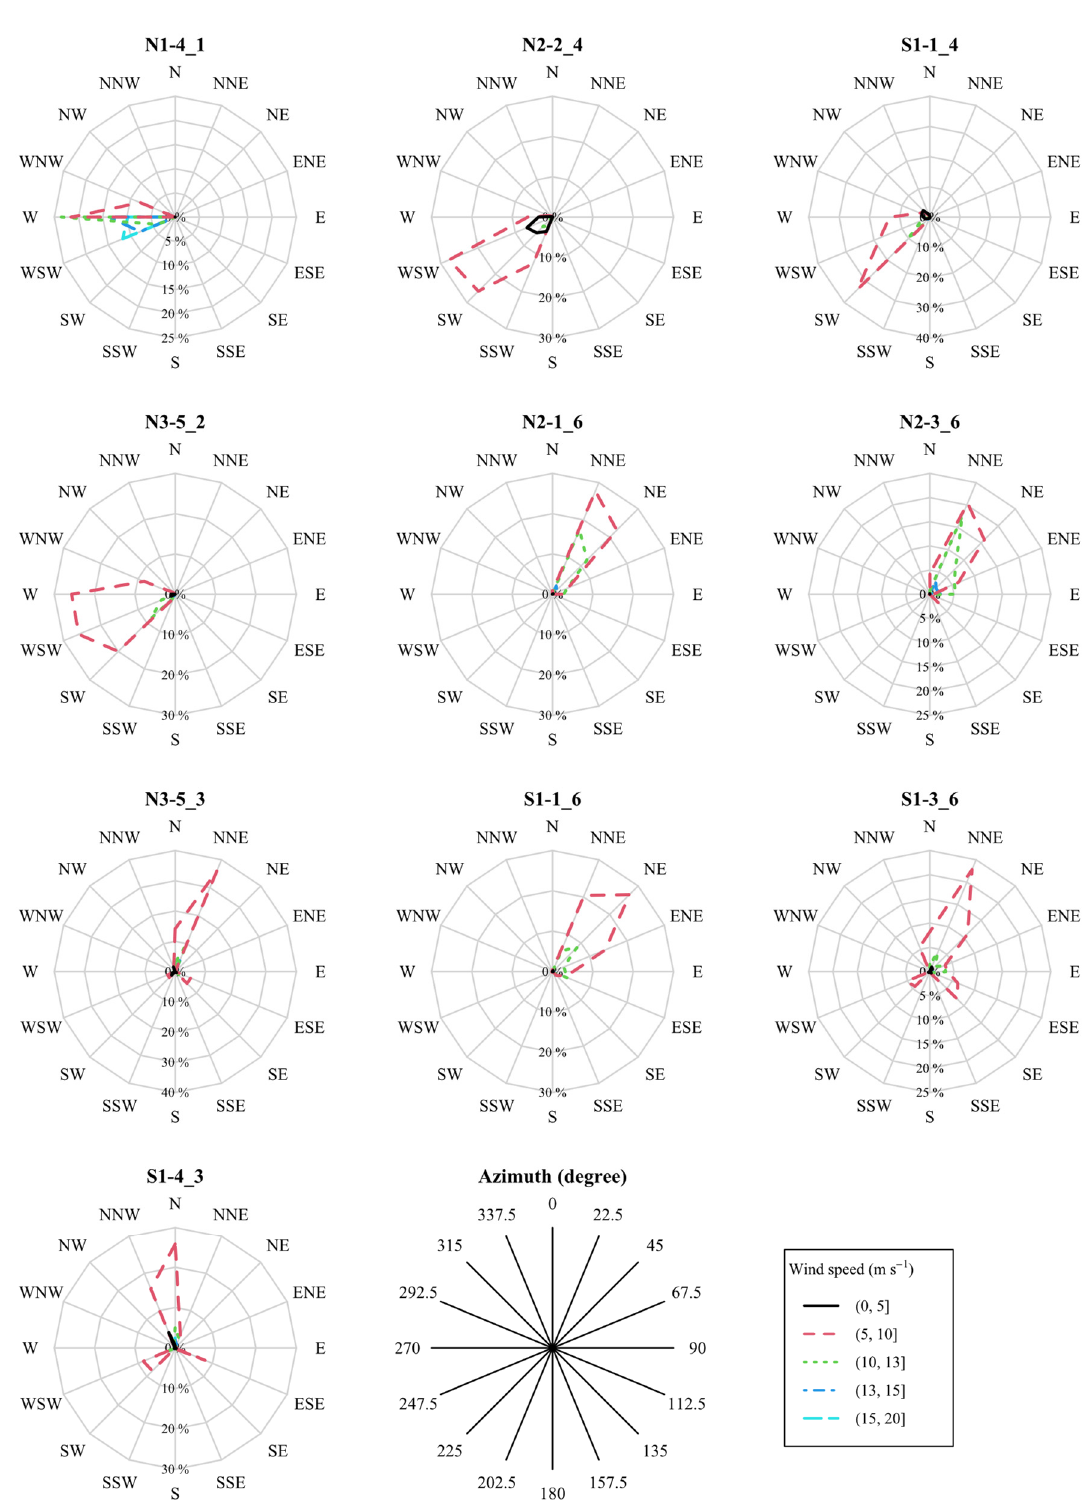
Figure 4. Frequency distribution of wind speed and direction for each site event used in the regression analysis. We estimated three relationships by multiple linear regression. Firstly, we examined the relationship between threshold friction velocity 𝑢 ∗(cid:2930) and roughness length normalized by community height 𝑧 (cid:2868) /ℎ . Secondly, we verified the relationship between the coefficient c and vegetation elements (vegetation cover and distance between shrubs ( 𝐷(cid:3365)/ℎ )) and their